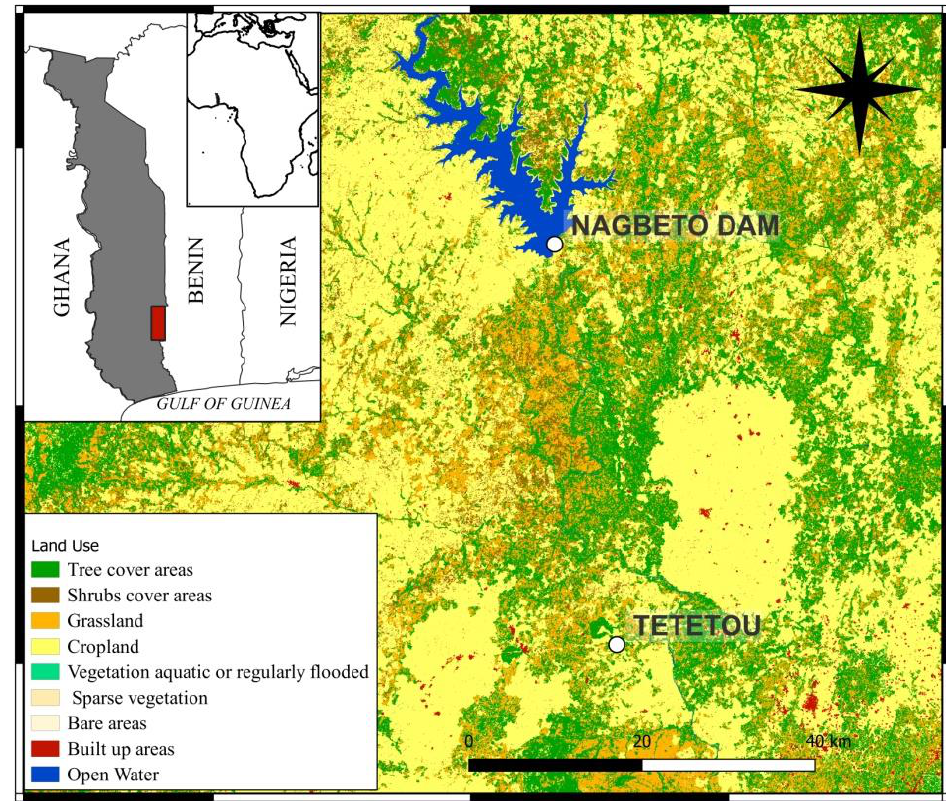
Figure 1. Map of southern Togo, showing the study area. The land use is also included.